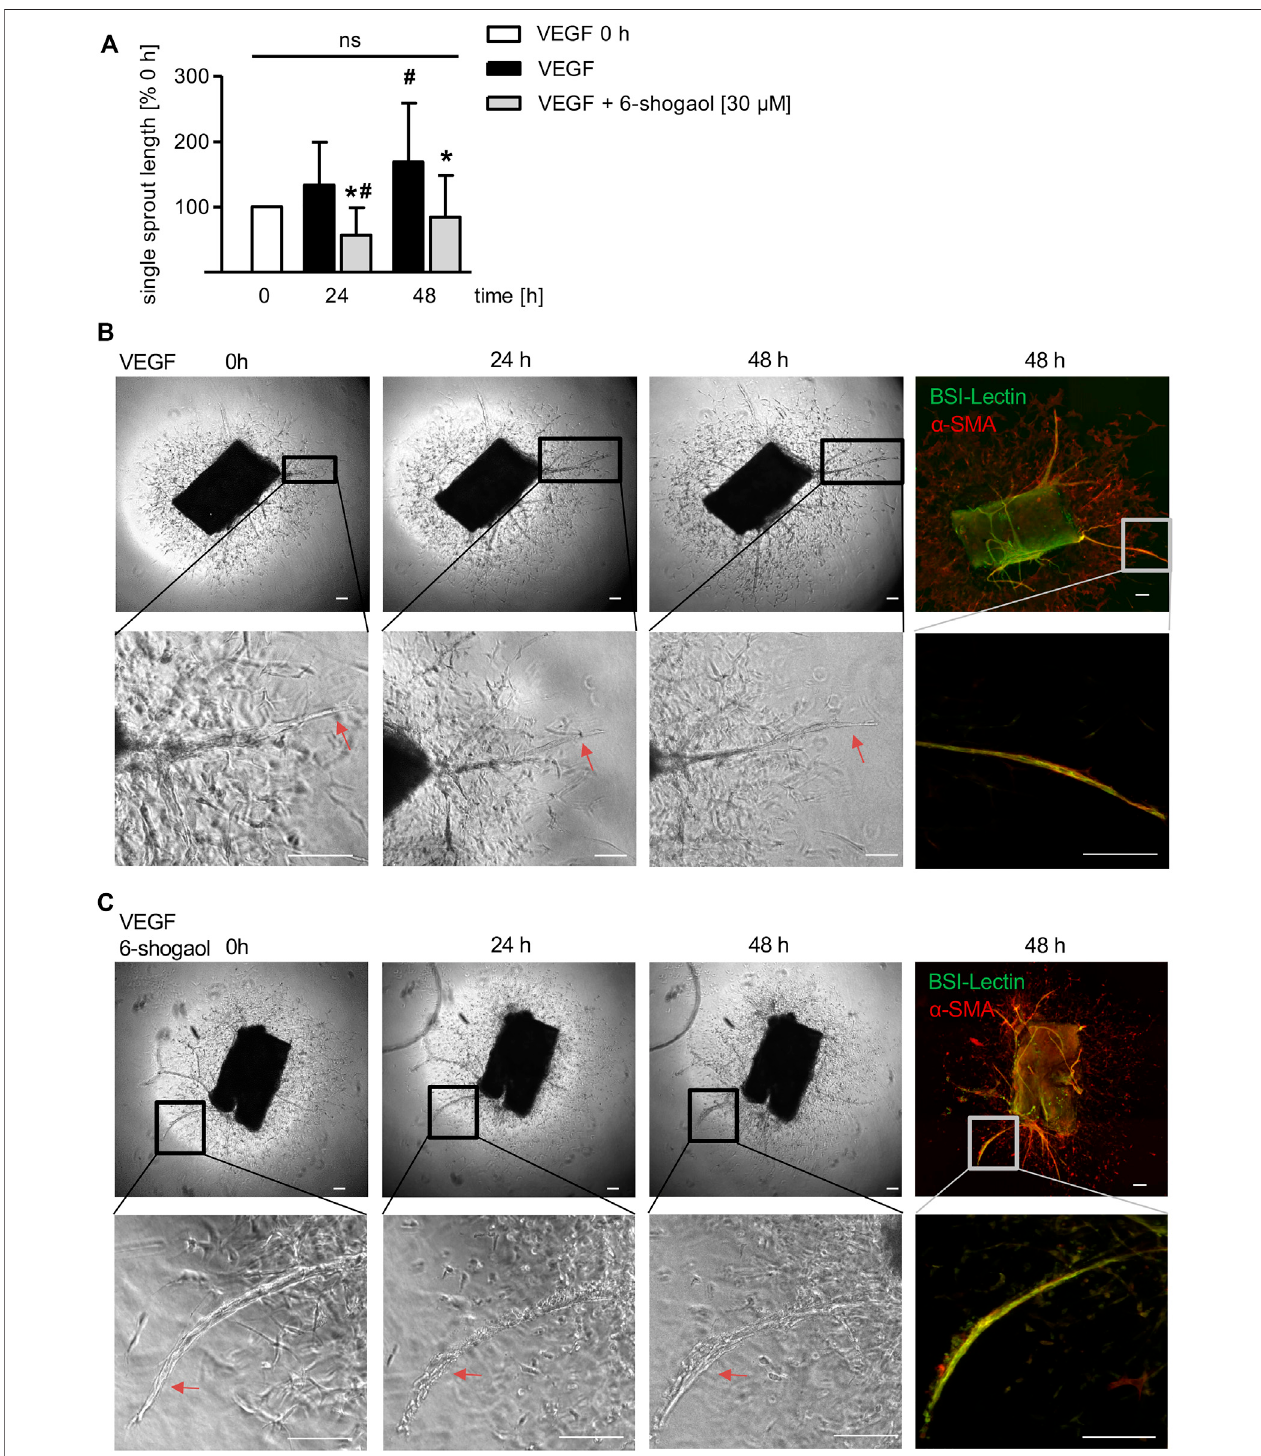
FIGURE6 | 6-Shogaol exhibits avascular-disruptive impact on angiogenic sprouts from murine aortae. Murine aortic rings wereembedded into arat tail collagen I gel.TheringswereallowedtoformVEGF-induced(30 ng/ml)angiogenicsproutsfor6 – 9 daysbeforetheyweretreatedwith6-shogaolfor24and48 h.Aorticringswere fi xed and stained for BS-I lectin (green) and α -smooth muscle actin (red). (B,C) Laser confocal scanning microscopy, phase contrast microscopy, and ImageJ allowed (A) the quanti fi cation of sprout length. Higher magni fi cation shows the effect of (C) 6-shogaol or (B) vehicle (0.03% DMSO) on already existing vessels. Scale bar represents 100 μ m, one representative image is shown, and red arrows highlight the compound-derived impact on preexisting vessels. ns, not signi fi cant. Data are expressed as mean ± SD; (A) n = 3; * p ≤ 0.05 vs. VEGF; # p ≤ 0.05 vs. VEGF 0 h.